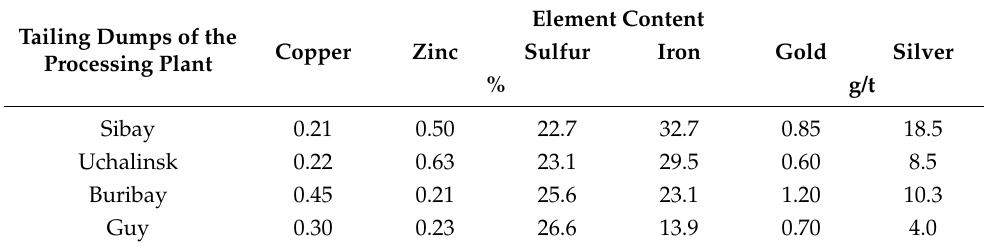
Table 2. Useful component content of man-made formations of the Southern Urals. Tailing Dumps of